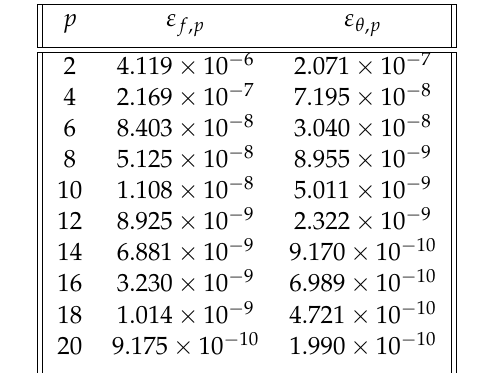
Table 3. Values of ε f , p and ε θ , p